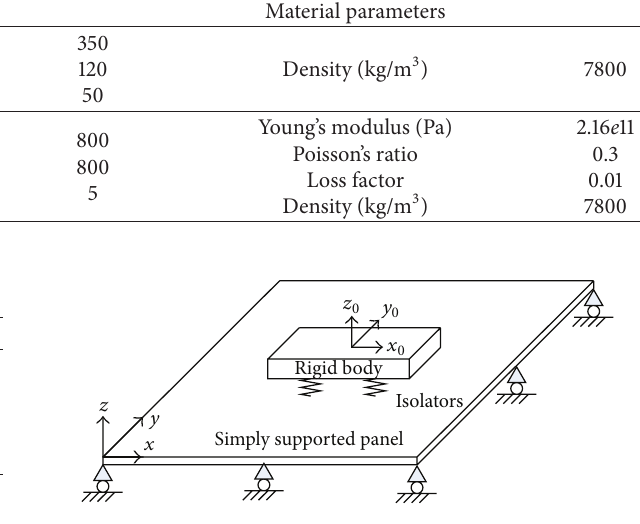
Figure 2: Schematic of vibration isolation